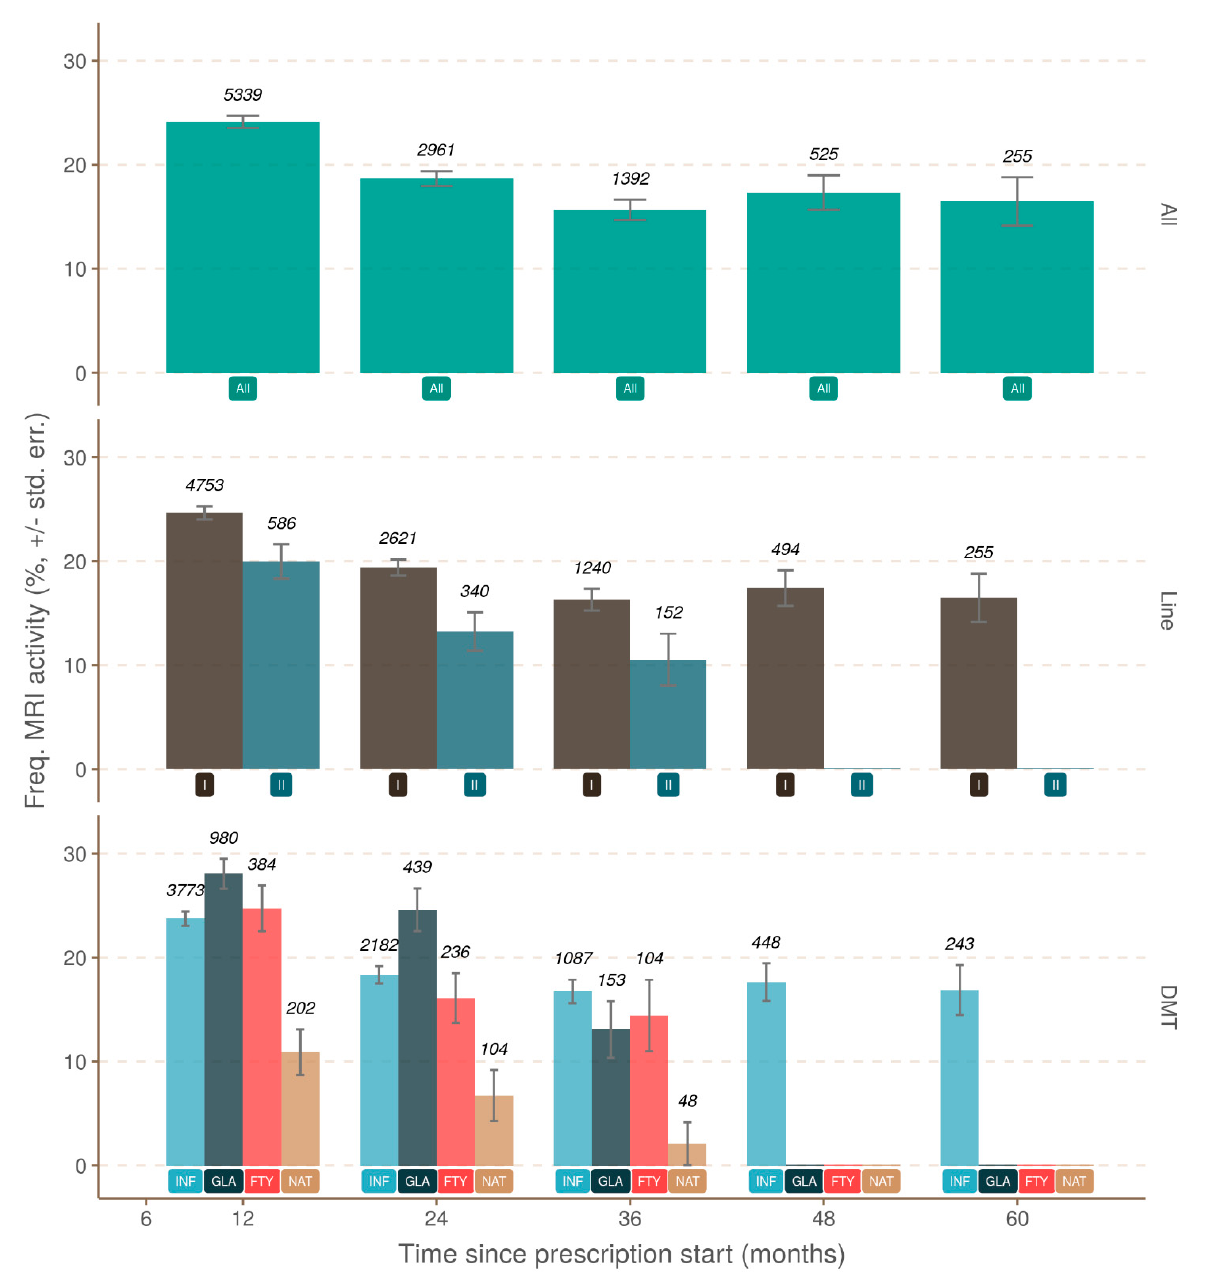
Figure 5. Comparison between the observed frequencies of MRI activity and month of observation when no relapse was ever recorded. The upper pane uses the complete set of observations (green; label at y = 1 is “All”), the middle pane uses first- and second-line treatment (label at y = 1; first-line, dark brown; second-line, dark blue), and the lower pane uses the drug (label at y = 1; Fingolimod, red, FTY; Glatiramer Acetate, dark blue, GLA; Interferon, blue, INF; Natalizumab, light brown, NAT). DMT: disease-modifying therapy.